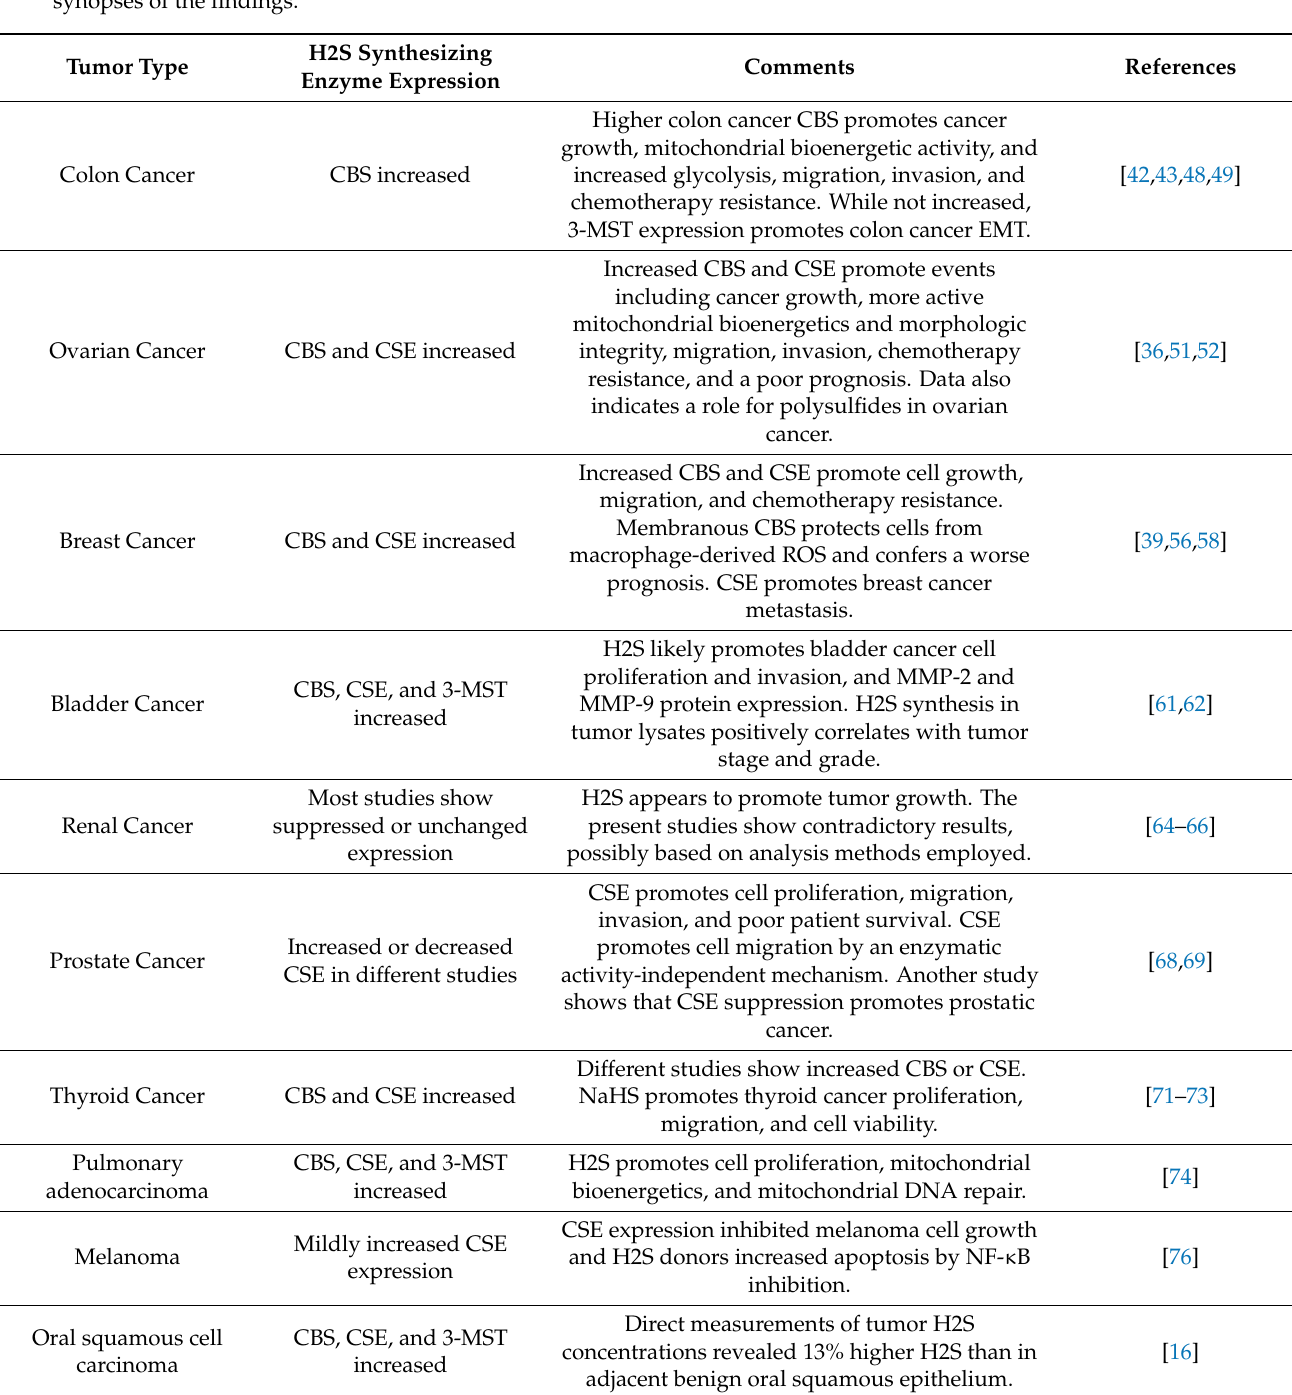
Table 1. A summary of the expression patterns of CBS, CSE, and 3-MST in several different human malignancies and synopses of the